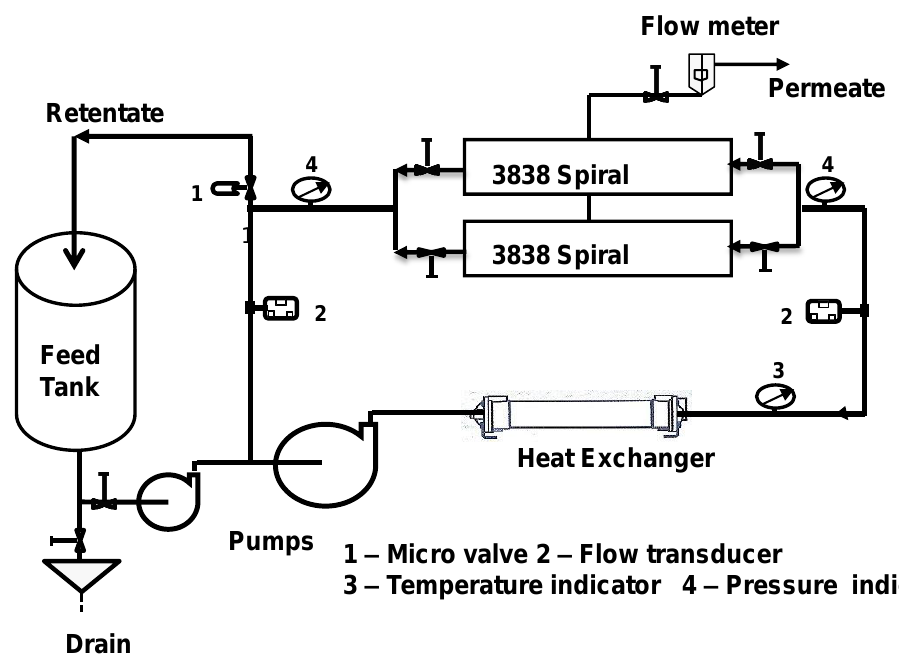
Figure 1. Pilot MF/UF unit set up.